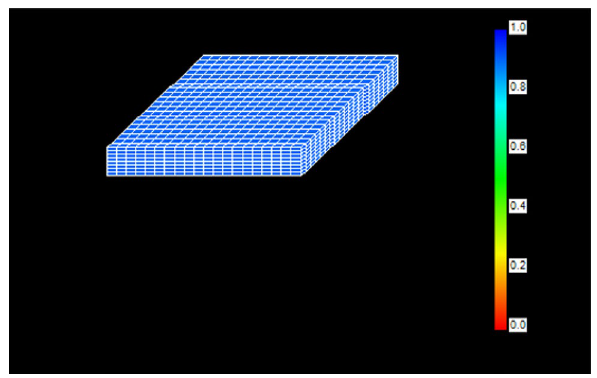
Fig. 16 Schematic of Cartesian gridding in FDGRS